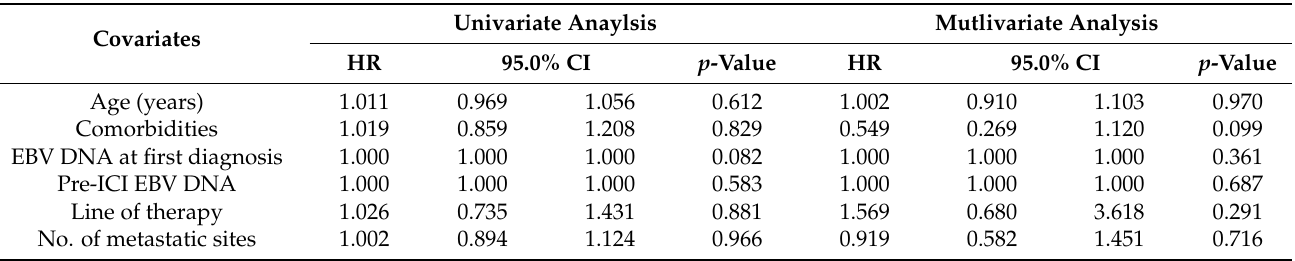
Figure 3. Presence of more than three metastatic sites is associated with worse PFS ( p = 0.023). No other demographics or disease features correlated with survival. Multivariate Cox proportional hazard models did not reveal any independent prognostic factors for PFS or OS (Table 2). Table 2. Prognostic factors for overall survival. Abbrev. EBV = Epstein–Barr Virus, ICI = Immune Checkpoint